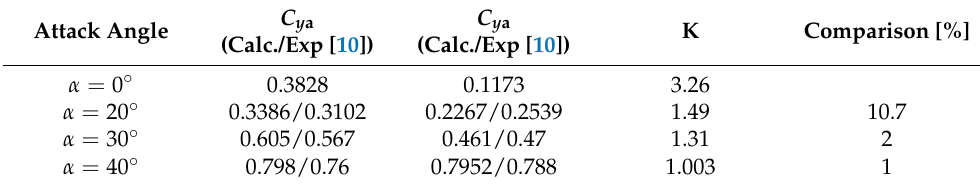
Table 2. Aerodynamic coefficients for the X-33 model.